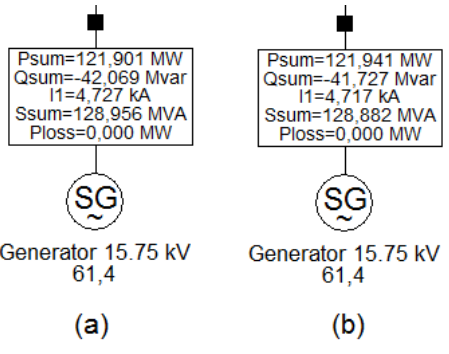
Fig. 6. The influence of asymmetrical loads: symmetrical (a), asymmetrical (b). The simulations show that the difference in active power is about 40 kW. Despite the small difference in power, the yearly economy of nearly EUR 5,045 per year could be achieved. For the calculations, the price of 0.0144 EUR/kWh for 6 kV level in Estonia was taken [12]. The effect of unbalanced loads in low voltage level is more significant, because the price in this case is about 0.0482 EUR/kWh [13].